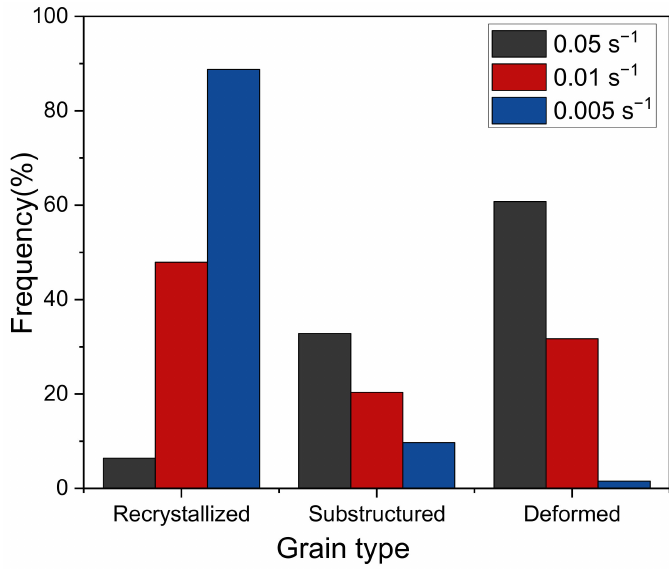
Figure 12. The volume fraction of different